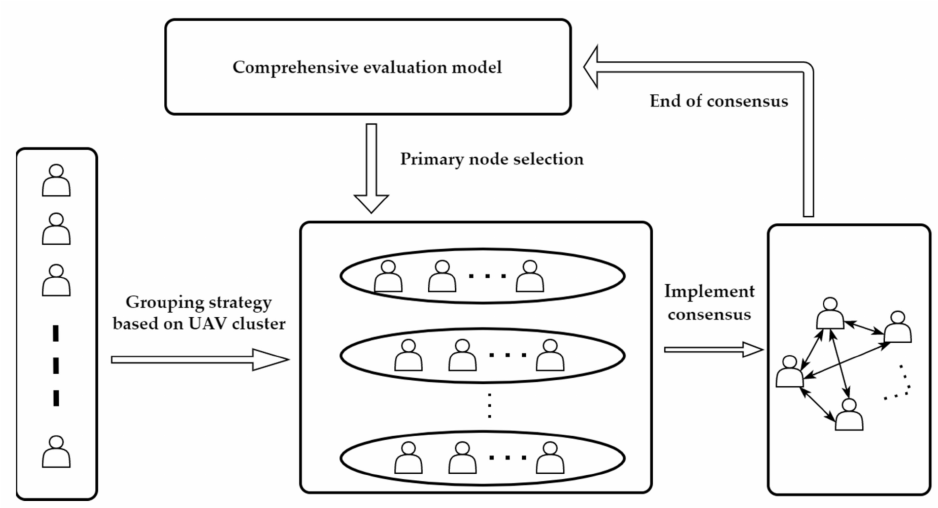
Figure 2. TB-PBFT Algorithm